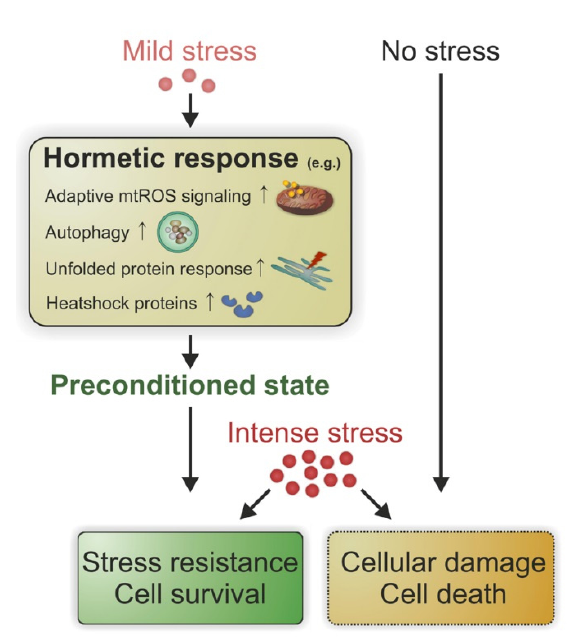
FIGURE 1: Hormesis governs a pleiotropic pro-survival program. When exposed to mild stress, cells/organisms respond by a vari- ety of adaptive cellular programs that procure a preconditioned state. When an intense stress is applied subsequently, precondi- tioned but not naïve cells/organisms exhibit stress resistance and eventually improved survival. mtROS, mitochondrial reactive oxygen